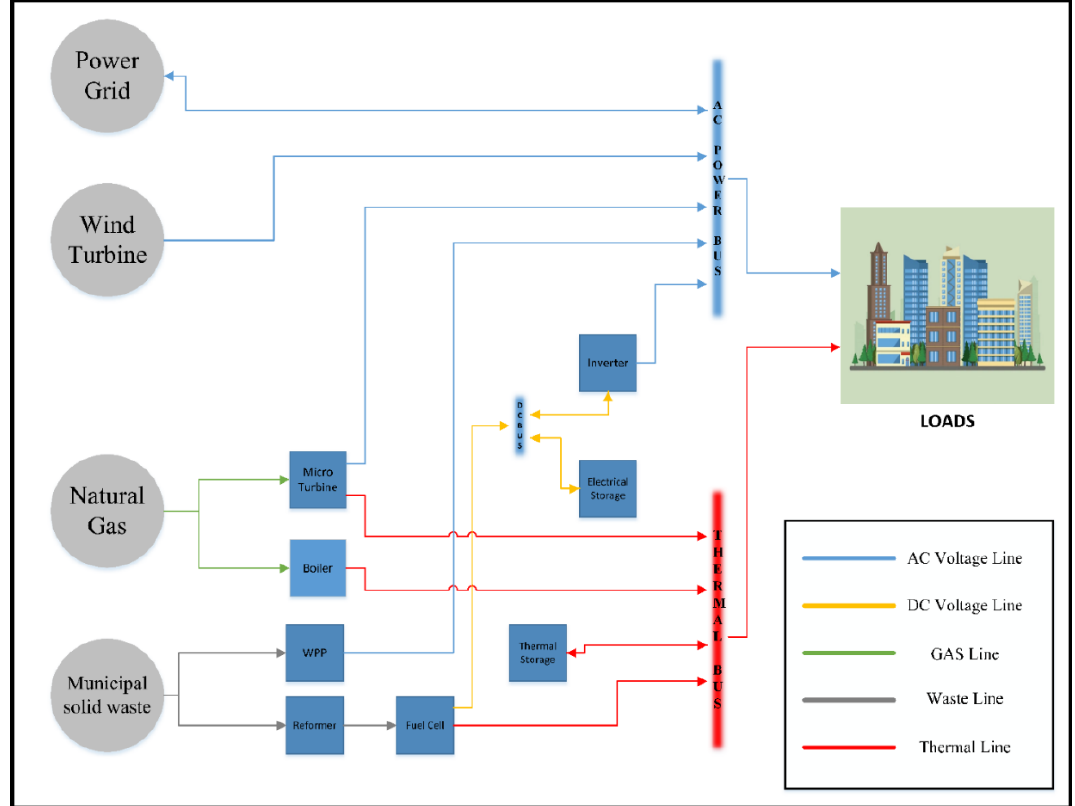
Figure 1. Structure of the proposed MEMG.